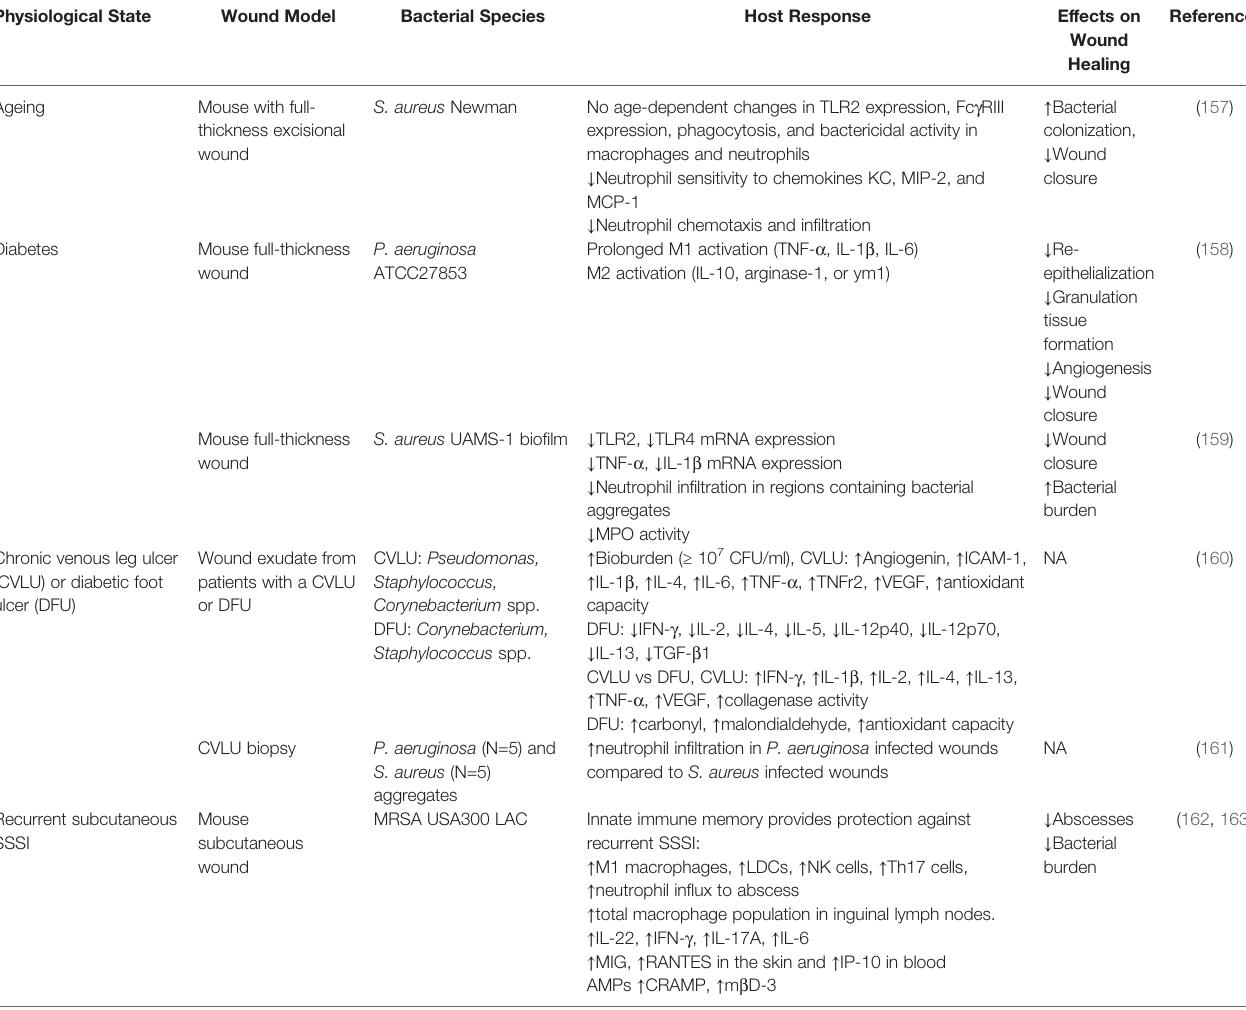
TABLE 4 | Summary of other physiological factors that modify the in fl ammatory responses to bacteria in wound models. Physiological